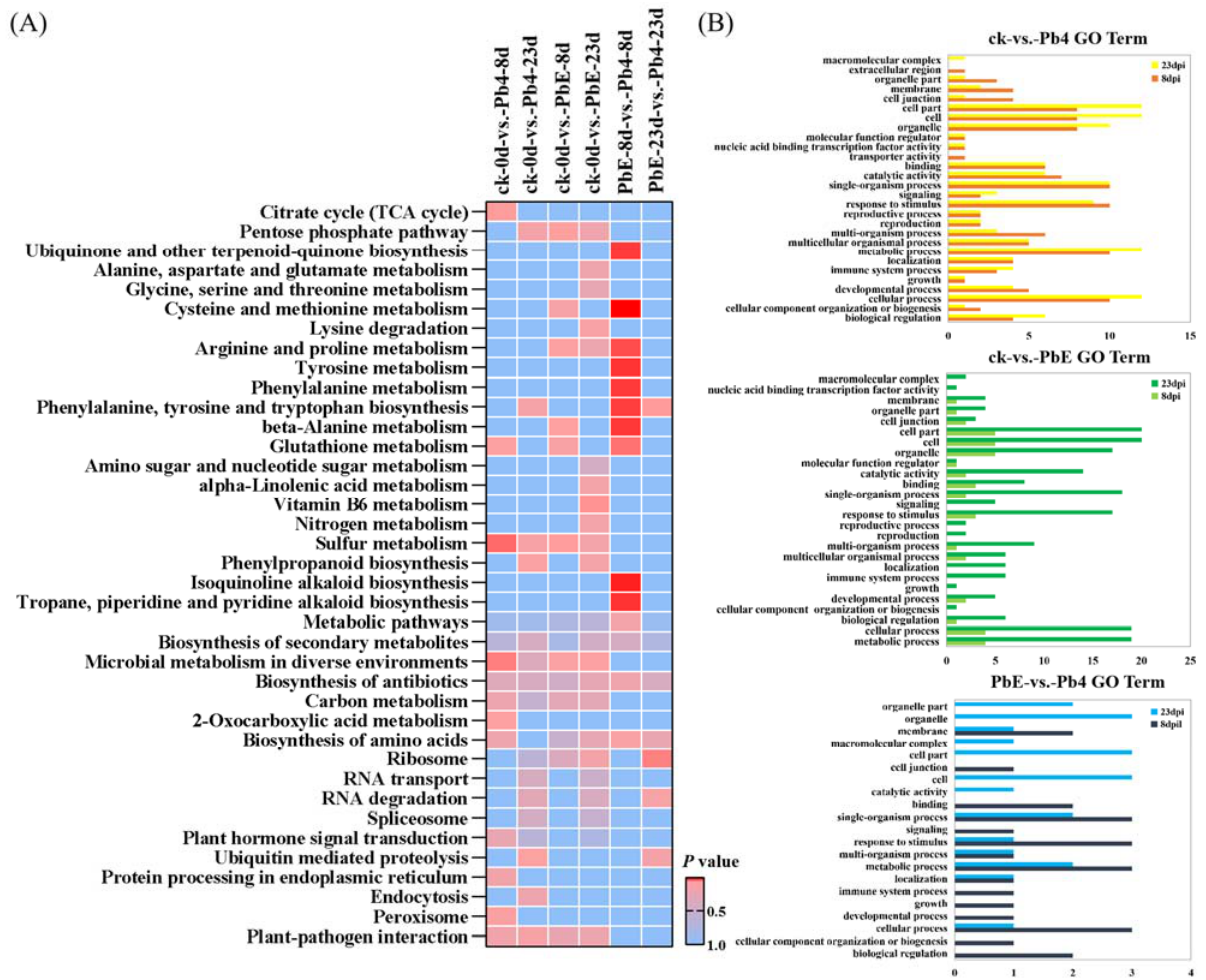
Figure 4. ( A ) KEGG pathway enrichment analysis of the differentially expressed parental genes in response to P. brassicae infection at 8 and 23 dpi. ( B ) Gene ontology (GO) classifications of the differentially expressed parental genes in response to P. brassicae infection at 8 and 23 dpi. GO classifications are listed on the left, whereas the gene numbers are shown on the right. GO classifications in the control vs. Pb4 comparison at 8 dpi and 23 dpi. Table 2. The circRNAs and their parental genes in each comparison.